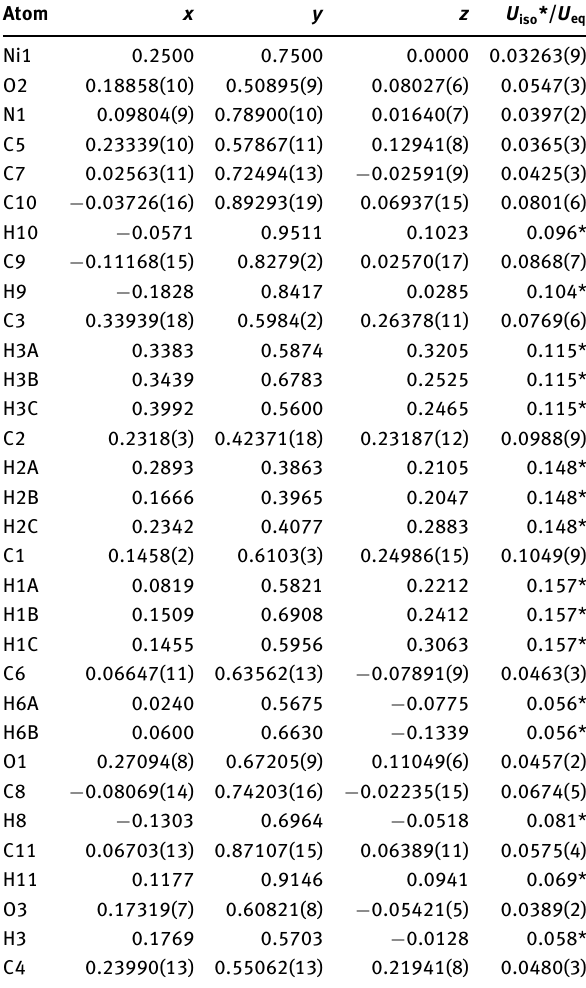
Table 2: Fractional atomic coordinates and isotropic or equivalent isotropic displacement parameters (Å 2